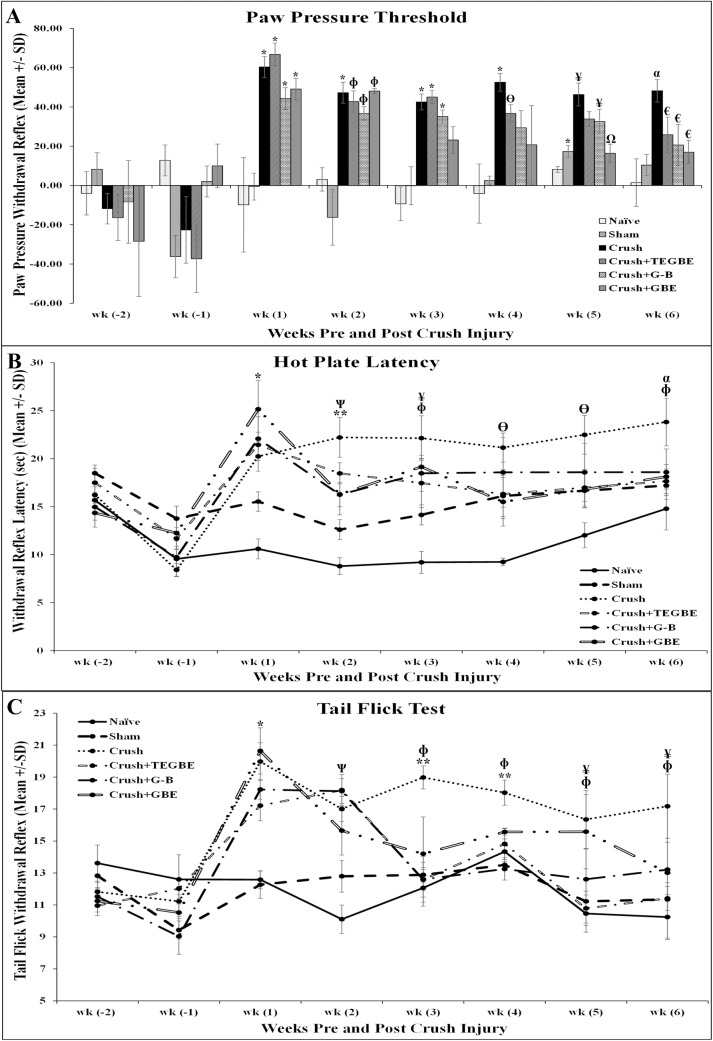
Sensory tests.A: Nociceptive mechanical thresholds expressed in grams were measured with an analgesic meter, 2 weeks before nerve crush injury till week 6 post-surgery. As time progressed, all treated rats showed trending recovery toward value = 0, indicating that mechanical hyperalgesia as measured by paw withdrawal reflex to nociceptive mechanical pressure was affected by all treatments compared to crush animals (n = 12). GBE (n = 6) was most effective treatment, by the end of week 6 with a significant decrease in PPT latency. PPT latencies were significantly increased in crush animals compared to sham (n = 12) by the end of week 6. * indicates p<0.0001, crush group and treated groups (TEGBE (n = 12), G-B (n = 12) and GBE) vs. naive (n = 6) and sham groups. ɸ indicates p<0.01, all treated groups with TEGBE, G-B and GBE vs. naive and sham groups. ϴ indicates p<0.03, TEGBE treated group vs. naive group. ¥ indicates p<0.05, TEGBE and G-B treated groups vs. naive and sham groups. Ω indicates p<0.01, GBE treated group vs. crush group. α indicates p<0.05, crush group vs. naive and sham groups. € indicates p<0.05, all treated groups (TEGBE, G-B and GBE) vs. crush group. B: Withdrawal reflex latency performed 2 weeks pre-surgery until week 6 post-surgery. Withdrawal reflex is defined as the time elapsed from the onset of hotplate contact to the withdrawal of the hind paw and measured in seconds. The affected limbs were tested twice with a one-hour interval between consecutive tests to prevent any sanitization or injury. The average readings were reported to obtain the final result. The cut-off time for heat stimulation was set at 30 s to avoid skin damage to the foot. Nerve crush injury produced a severe nociception deficit in the crush and crush-treated groups at week two following nerve injury. The TEGBE, G-B and GBE-treated animals showed a significant thermal nociceptive recovery by week 2 post-injury. * indicates p<0.05, all treated groups (TEGBE, G-B and GBE) and crush group vs. naive and sham groups. ** indicates p<0.05, TEGBE-treated group and crush group vs. naive and sham groups. Ѱ indicates p<0.05, G-B and GBE-treated groups vs. crush group. ɸ indicates p<0.05, crush group vs. naive and sham groups. ¥ indicates p<0.05, all treated groups (TEGBE, G-B and GBE) vs. naive group. ϴ indicates p<0.05, sham, crush and G-B -treated groups vs. naive group. α indicates p<0.05, TEGBE-treated group vs. crush group. Results are presented as mean ± SD. C: Time course of tail flick withdrawal latency in the different experimental groups. The spinally mediated nociceptive thresholds were determined by using an analgesia meter apparatus weekly from week 2 pre-surgery week till the end of week 6 post-surgery. The time taken for the tail to move was recorded in seconds as tail flick withdrawal reflex. The cutoff time was set on 25 sec to avoid any tissue damage. Two readings were taken and the all averages were obtained for the final values. Crush animals displayed significantly higher values for tail flick withdrawal latencies compared to naive and sham groups throughout the experiment. Whereas, The TEGBE, G-B and GBE-treated groups showed significant tail flick withdrawal latency recovery compared crush group by the end of week 3 post-injury. * indicates p<0.005, all treated groups (TEGBE, G-B and GBE) and crush group vs. naive and sham groups. Ѱ indicates p<0.05, crush group and TEGBE treated group vs. naive and sham groups. ɸ indicates P<0.05, crush group vs. naive and sham groups. ** indicates p<0.05, all treated groups (TEGBE, G-B and GBE) vs. crush group. ¥ indicates p<0.05, TEGBE treated group vs. crush group. Values are expressed as means ± SDs.